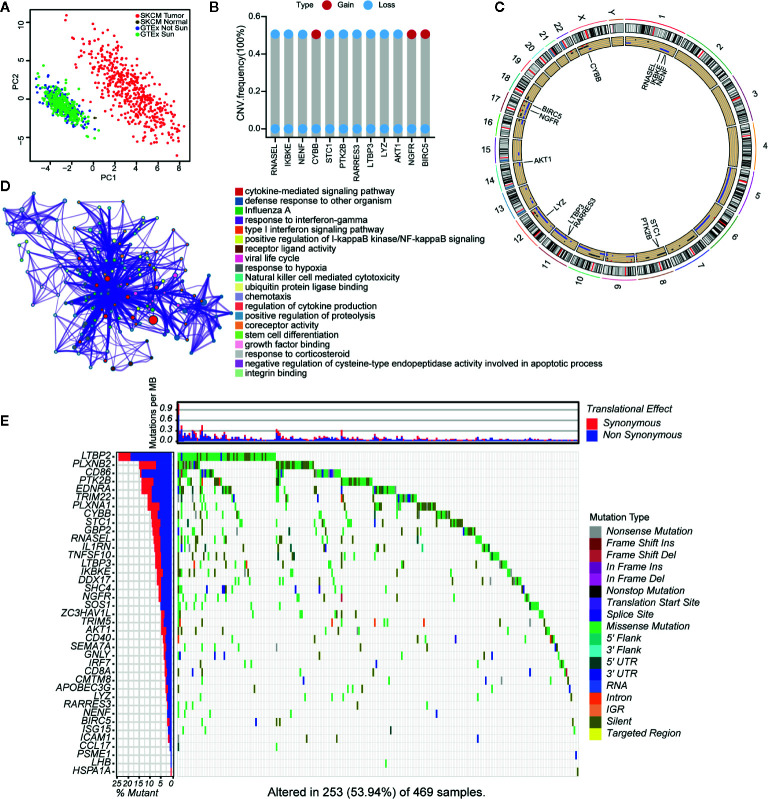
Landscape of genetic and expression variation of 39 IRGs in CM. (A) the Principal Component Analysis (PCA) of 39 unique IRGs to distinguish tumors and normal samples in TCGA cohort and GTEx normal skin cohort. Normal samples and tumor samples were identified without intersection, indicating the two subgroups were well distinguished based on the expression profiles of 39 IRGs. GTEx normal skin exposed sun were marked green, GTEx normal skin not exposed sun were marked blue, TCGA normal sample were marked gray and TCGA tumor samples were marked with red. (B) The CNV variation frequency of 12 IRGs in TCGA cohort. The blue dot meaning deletion frequency and the red dot meaning amplification frequency. The height of the column represented the alteration frequency. (C) The location of CNV alteration of 12 IRGs on 23 chromosomes using TCGA cohort. (D) The biological functional enrichment analysis and interaction network of enriched terms for 39 IRGs. (E) The mutation frequency of 39 IRGs in 460 patients with CM from TCGA mutation dataset. Each column represented individual patients. The number on the left showed the mutation frequency in each gene. The upper barplot showed the mutations per MB, Synonymous, red; Non Synonymous, blue. The right annotation list showed the different variant type.